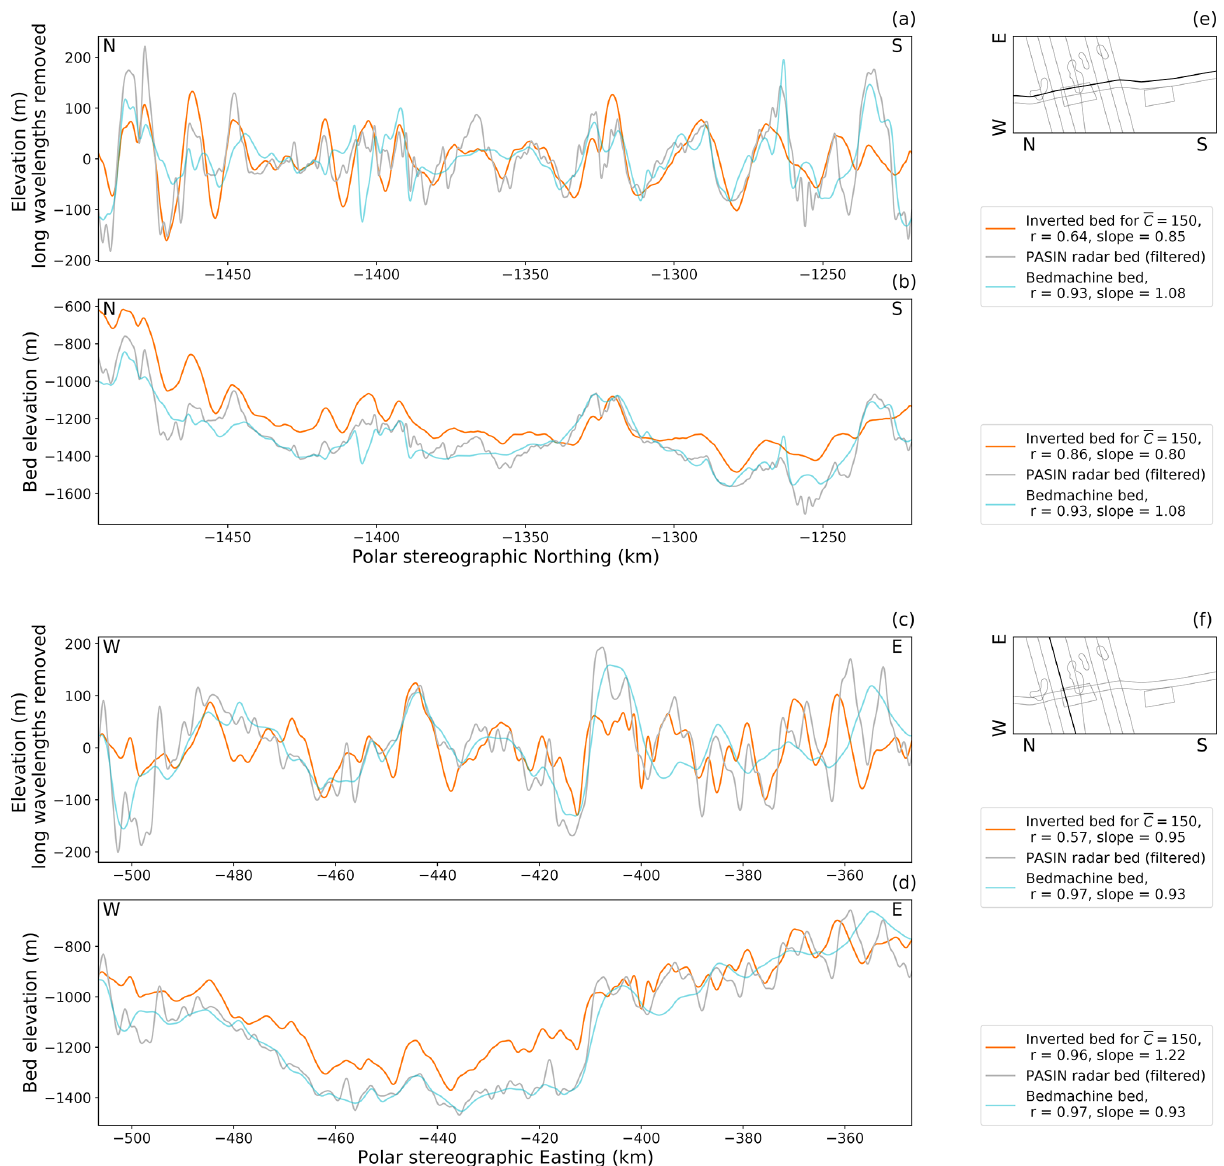
Figure 10. The results of the inversion (orange) compared to PASIN radar flight lines (grey) and BedMachine Antarctica (light blue) for an along-flow profile and an across-flow profile (locations shown in panels e and f , respectively). Panels (b) and (d) show the bed profiles. Panels (a) and (c) show the results with any Fourier components between 40 and 50km in wavelength progressively damped with a half- cosine filter and any Fourier components over 50km in wavelength